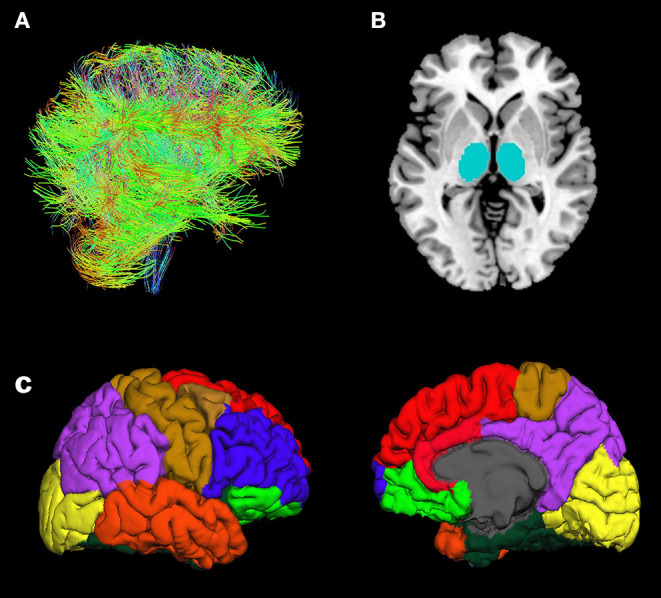
Illustration of fiber tracts (A), thalamus ROIs (seed regions) (B), and cortical ROIs (target regions) (C): orbitofrontal cortex (yellow-green), medial prefrontal cortex (red), lateral prefrontal cortex (blue), sensorimotor cortex (brown), parietal cortex (purple), lateral temporal cortex (orange), medial temporal cortex (dark-green), and occipital cortex (yellow).